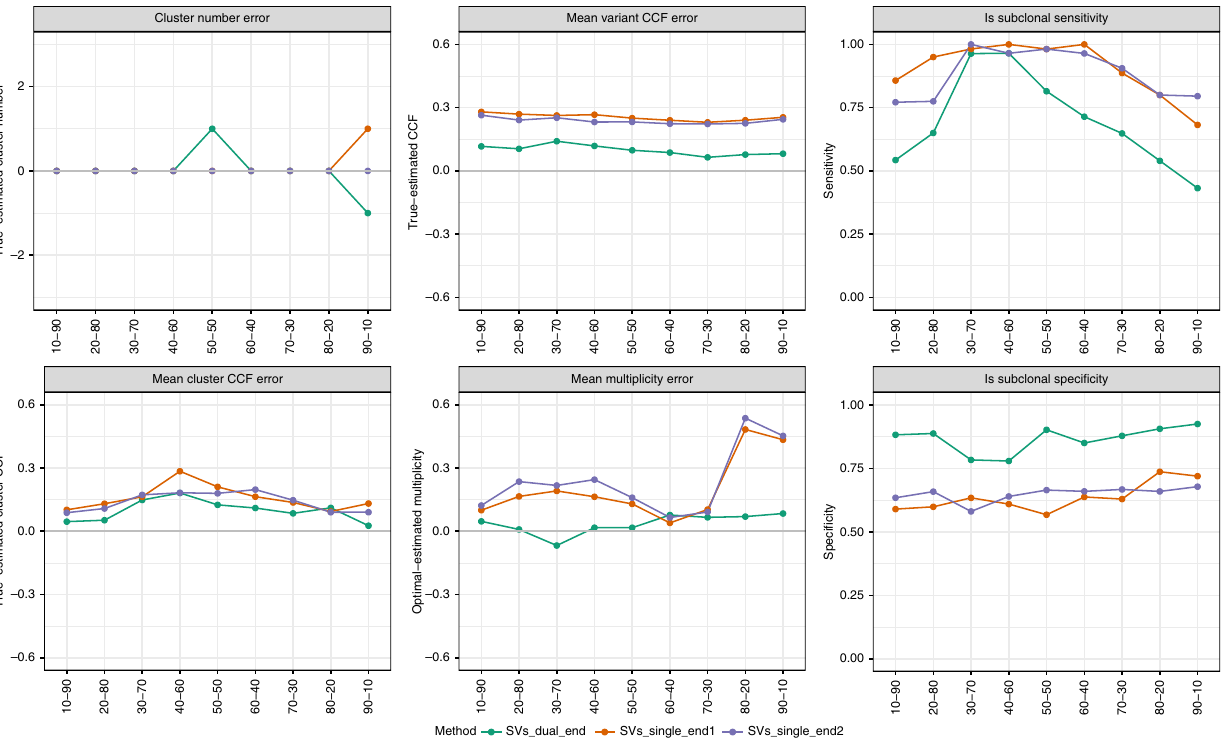
Fig. 4 SV clustering performance for dual versus single-end models. Performance of SVclone run on three-cluster in silico mixtures using either both breakends of an SV, or a single end. The fi rst column shows the cluster number error (three-inferred cluster number), and the mean CCF error, where true and inferred clusters are matched based on their order (see Methods). The second column shows the mean variant CCF and multiplicity error compared with the ground truth CCF. The third column shows the subclonal classi fi cation sensitivity and speci fi city using sample membership of the variant (i.e. a variant is classi fi ed as clonal if present in both samples of the mixture, and subclonal